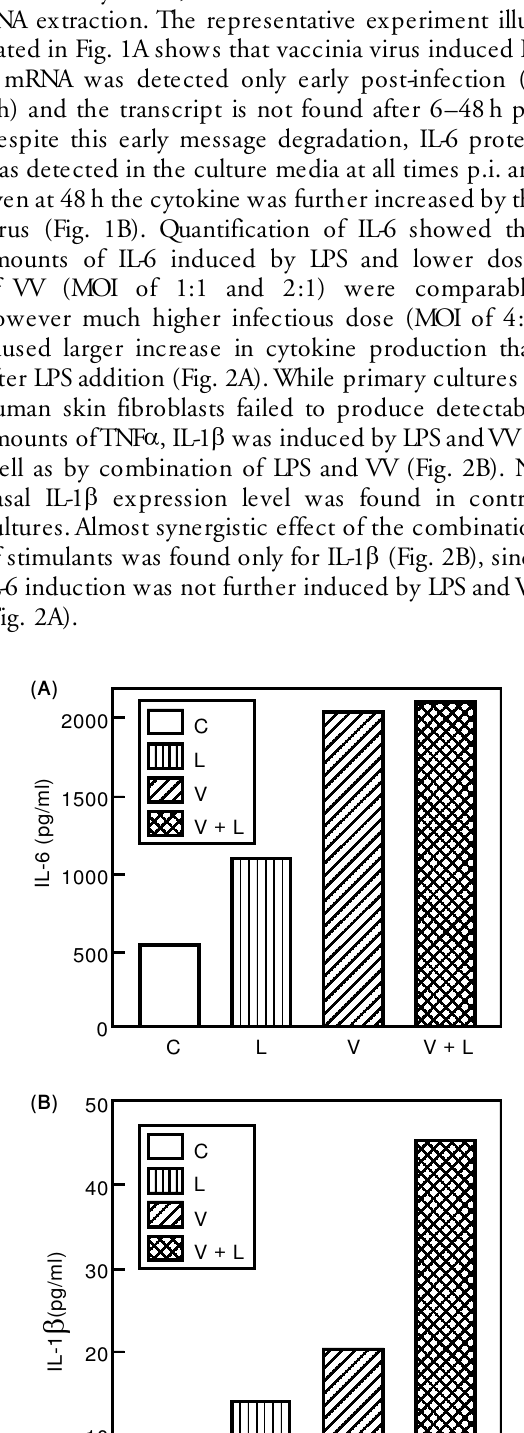
FIG. 1. IL-6 gene expression in vaccinia virus-infected human skin fibroblasts. Human skin fibroblasts remained either untreated (control–C), or were infected with vaccinia virus (V) (at MOI 2:1) or treated with LPS (L). After 4, 6 or 24h the cells were harvested for RNA extraction. 10 m g of total RNA was applied per lane for Northern blot analysis with IL-6 specific cDNA probe (A). IL-6 protein was determined by ELISA in culture media from four separate experiments (6 and 24h) and a single experiment (48h) (B). Results are expressed as the mean ± standard deviation. Statistically significant results and P values < 0.01 are marked by*.